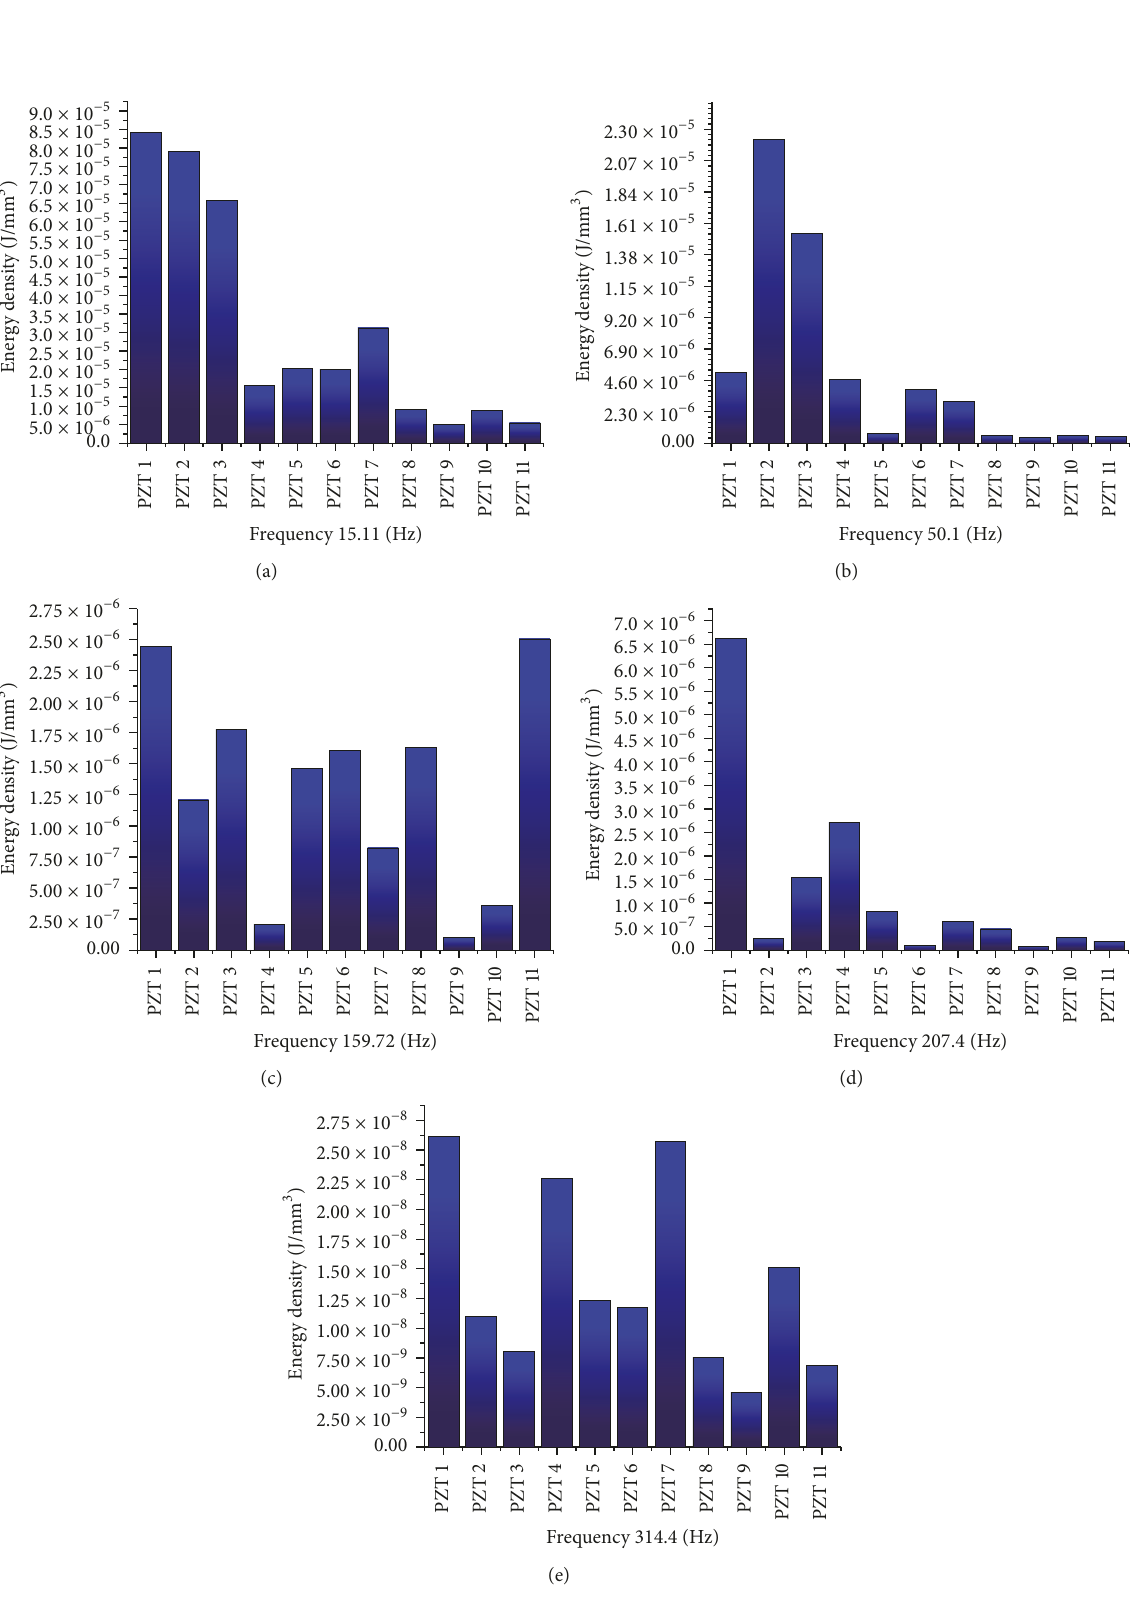
Figure 15: Energy density characteristics of the harvester at resonant frequencies: at (a) 15.11Hz; (b) 50.1 Hz; (c) 159.72 Hz; (d) 207.4 Hz; (e) 314.4